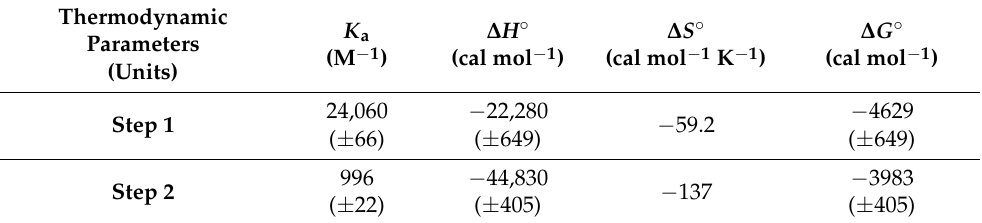
Figure 3. Typical thermogram of Mb with mixture of crowders (PEG 400 + EG) specifies ( A ) calori- metric response to the consecutive injection of the mixture injected to reaction cell and ( B ) provided by subsequent isothermic binding at 7.0 pH and 298 K (25 ◦ C). Table 1. Binding parameters of crowder mixture (PEG 400 + EG) with Mb measured from ITC using sequential binding isotherm at pH 7.0 and 298 K (25 ◦ C) a